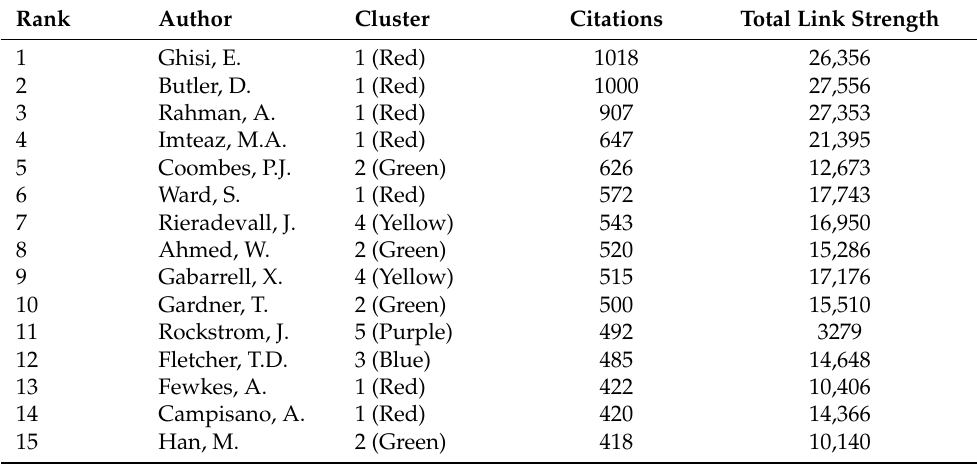
Table 7. The top 15 most co-cited